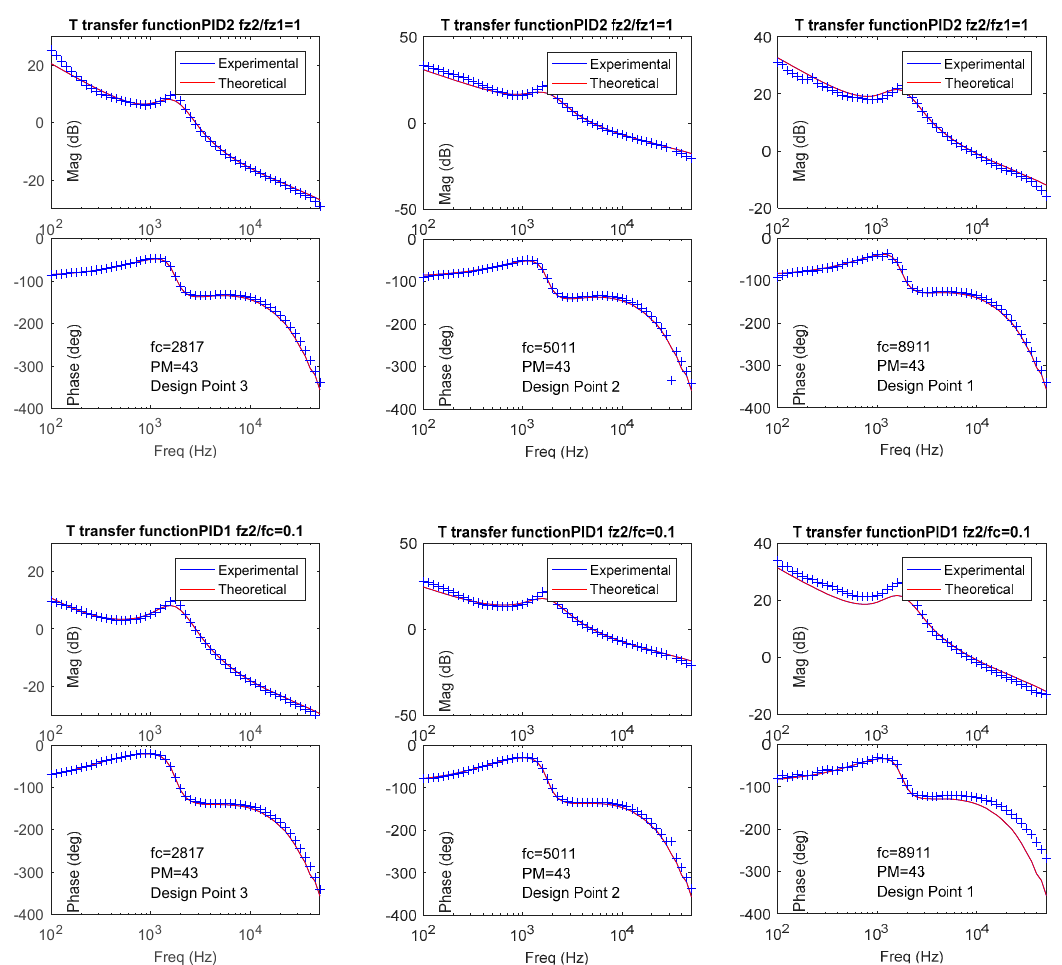
Figure 14. Comparison between the experimental measurements and the theoretical predictions for different PID compensators, considering the three design points in Figure 13.